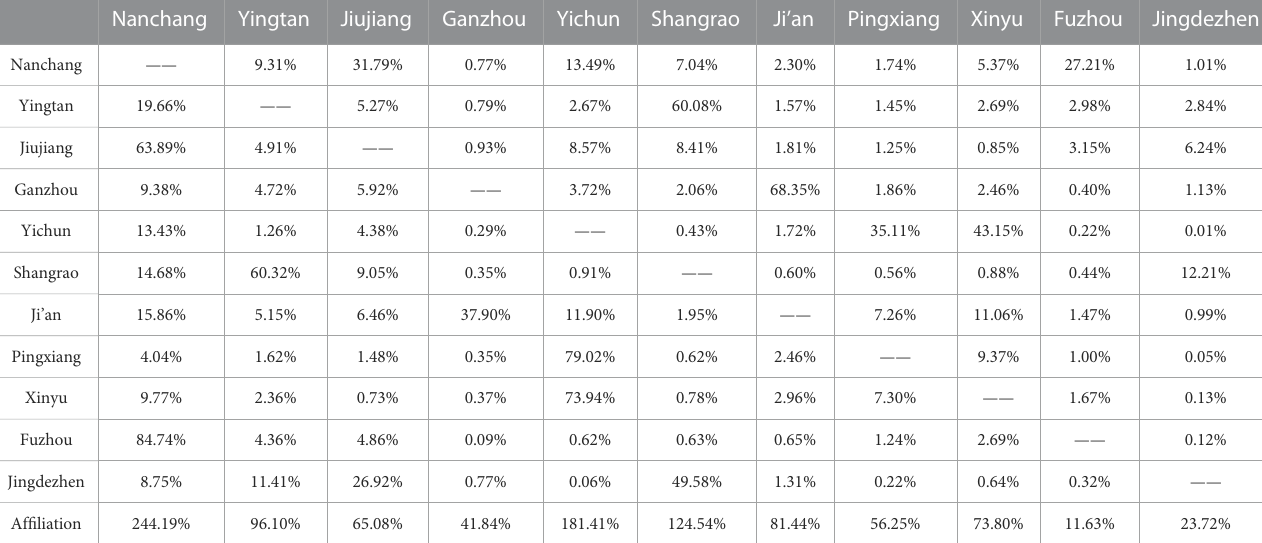
TABLE 11 Economic af fi liation of cities after the opening of high-speed rail. Nanchang